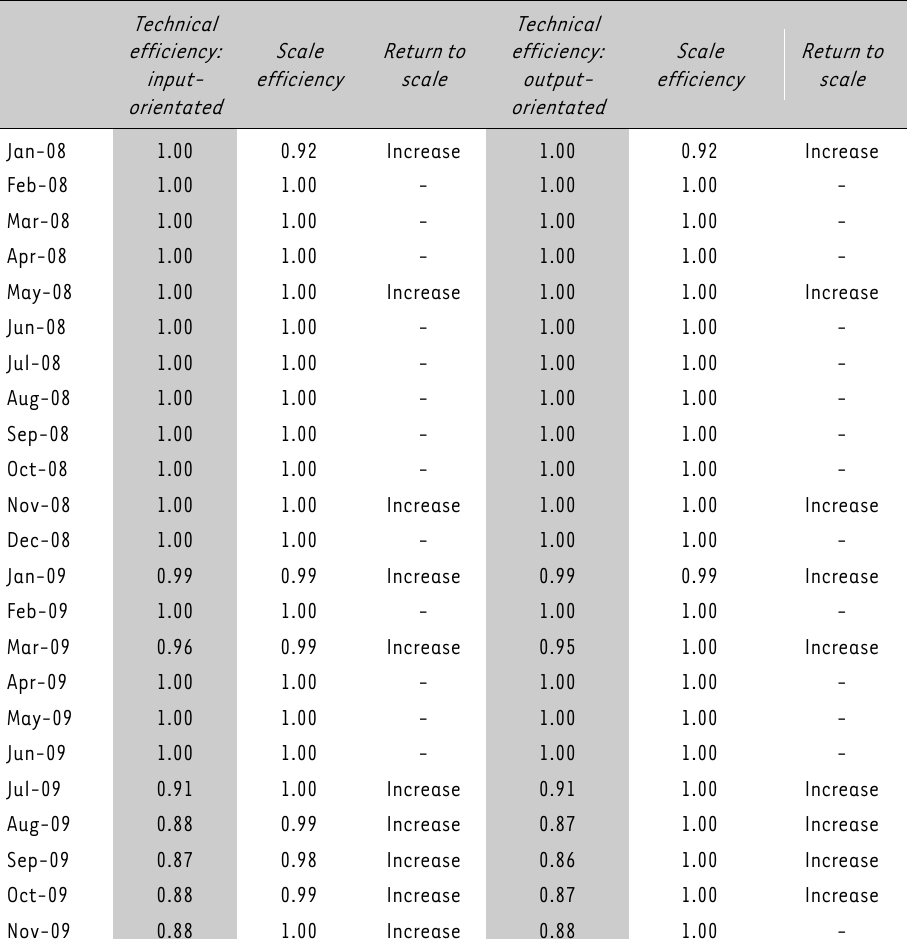
TABLE 18: Efficiency estimates: Investec